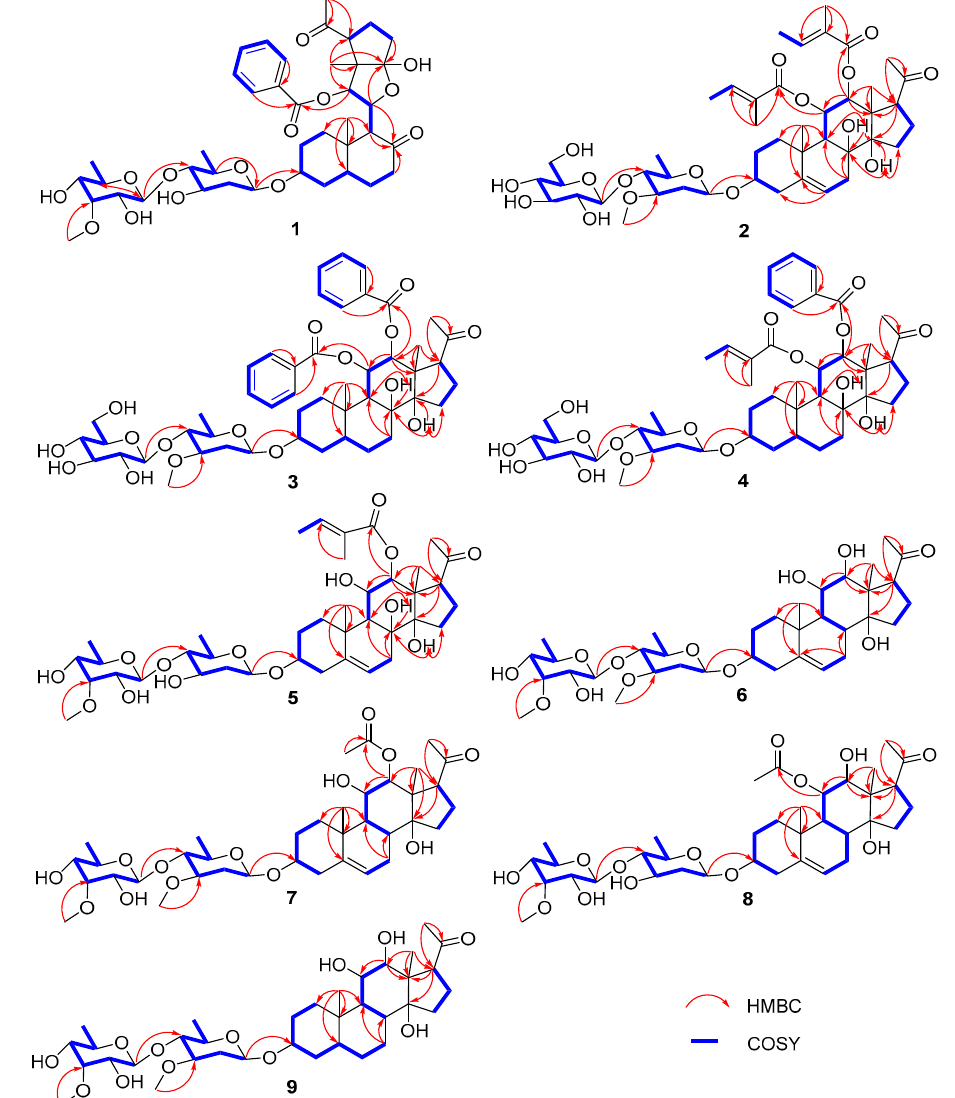
Figure 2. Selected HMBC and 1H–1H COSY correlations of compound 1 – 9